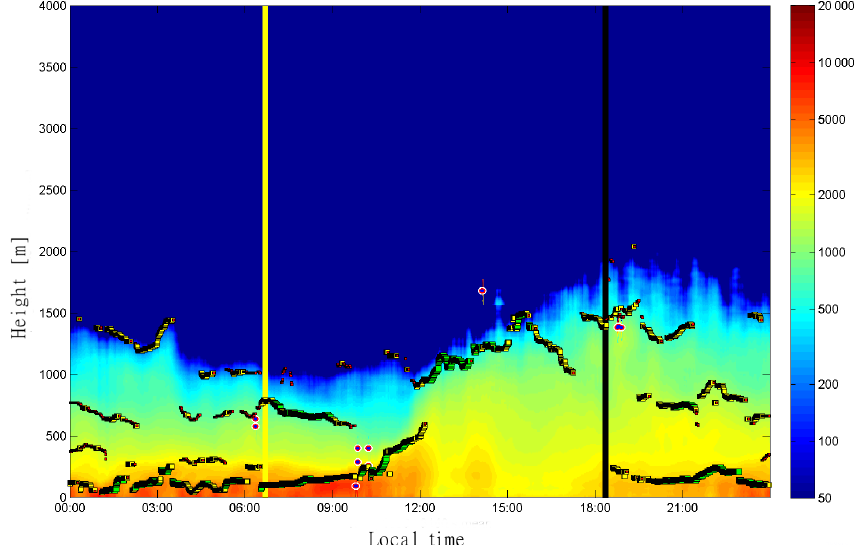
Figure 2. Attenuated backscatter density measured on 9 March 2014 (10 − 9 m − 1 sr − 1 ) together with the aerosol layers reported by BL-VIEW (rectangles) and cloud bases reported by the ceilometer (blue and red circles). The yellow and black vertical lines indicate sunrise and